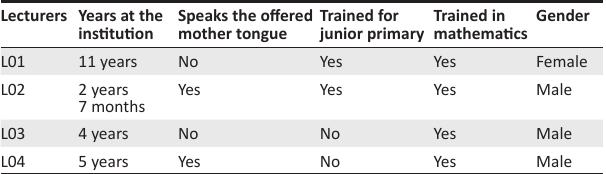
TABLE 1: Lecturers’